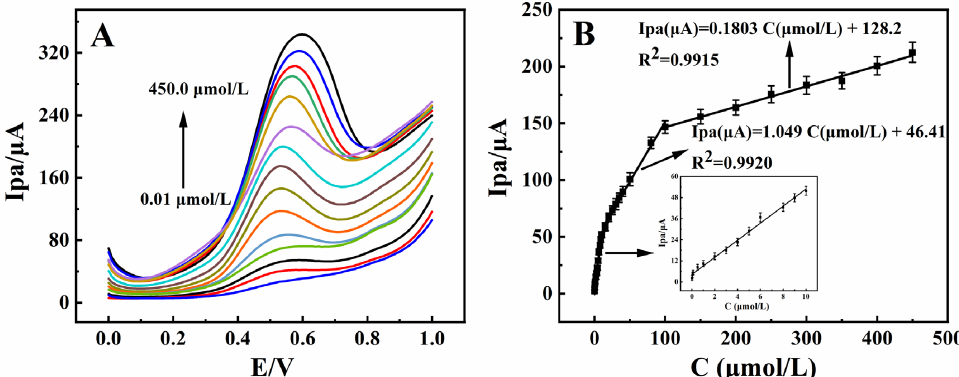
Figure 6. ( A ) DPV curves of different concentrations of 6,7-DHC from 0.01 to 450.0 µ mol/L in pH 3.0 PBS; ( B ) Linear relationship between Ipa and 6,7-DHC concentration (n = 3).